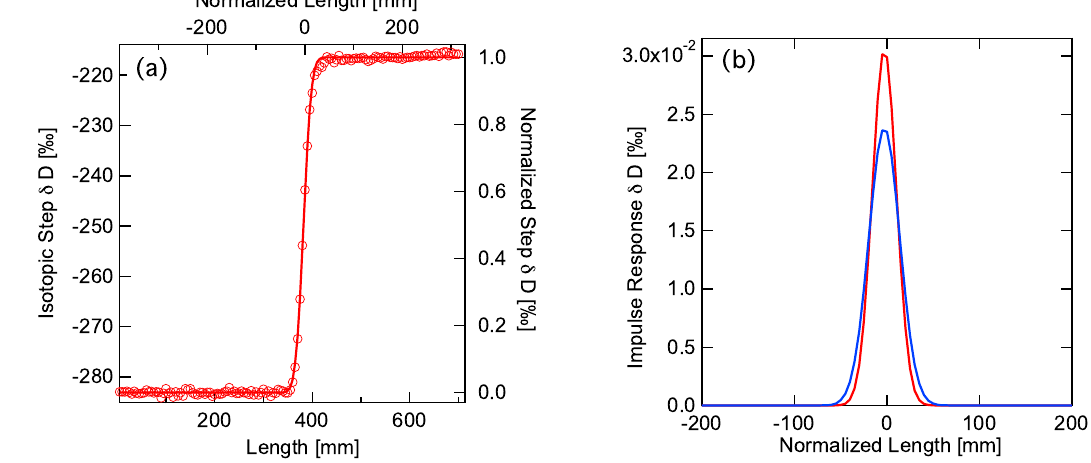
Fig. 7. (a) Isotopic δ D step. The length scale is normalized so normalized length = 0 when the normalized δ D value equals 0.5‰. (b) Impulse Response of the system for δ D based on the step response (red) and the spectral analysis (blue) with σ cfa = 13 . 4 and 16.4mm, respectively.